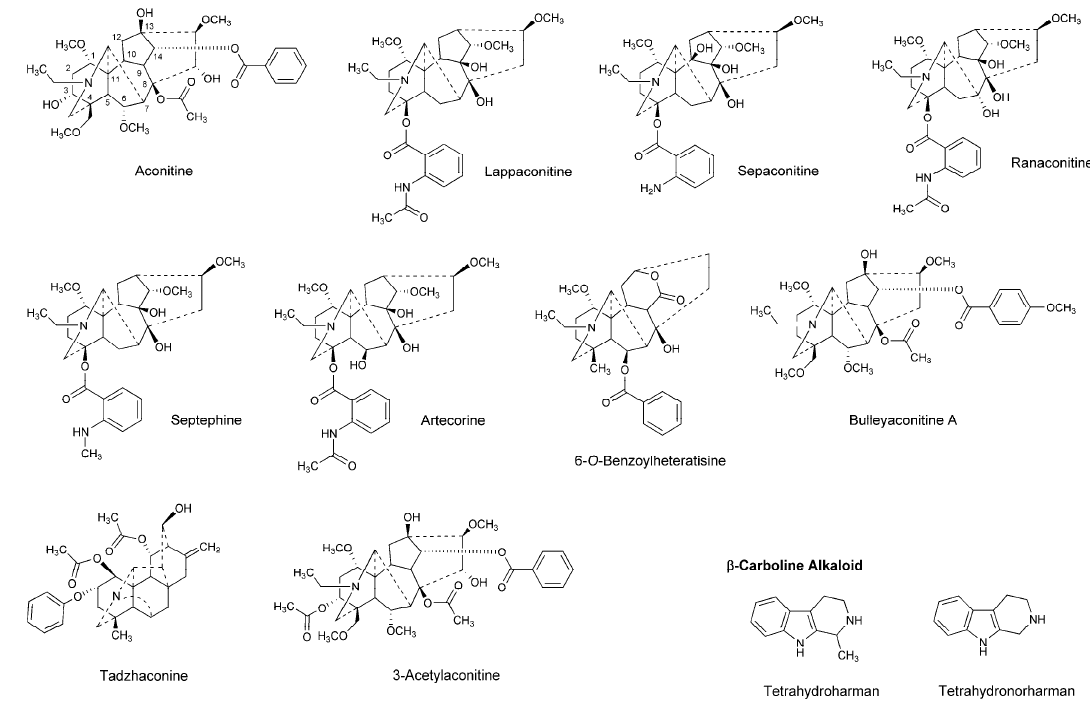
Figure 4. Alkaloids with the local anesthetic activity.